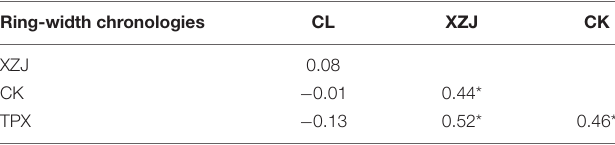
TABLE 3 | Correlation coefficients between four ring-width chronologies (from 2003 to